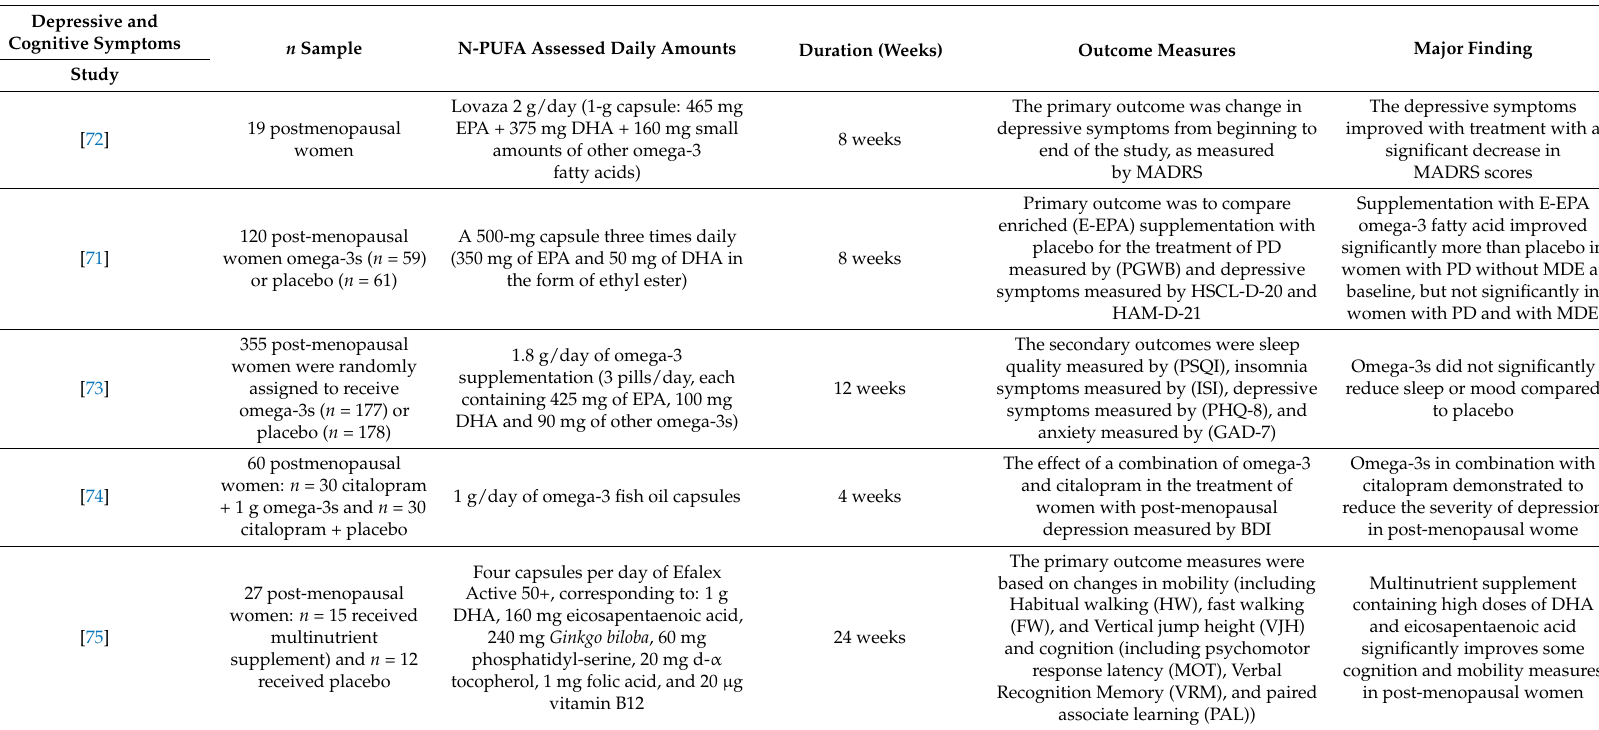
Table 1. Randomized controlled trials (RCTs) of n-3 long-chain polyunsaturated fatty acids (n-3 LCPUFAs) on menopausal depressive and cognitive